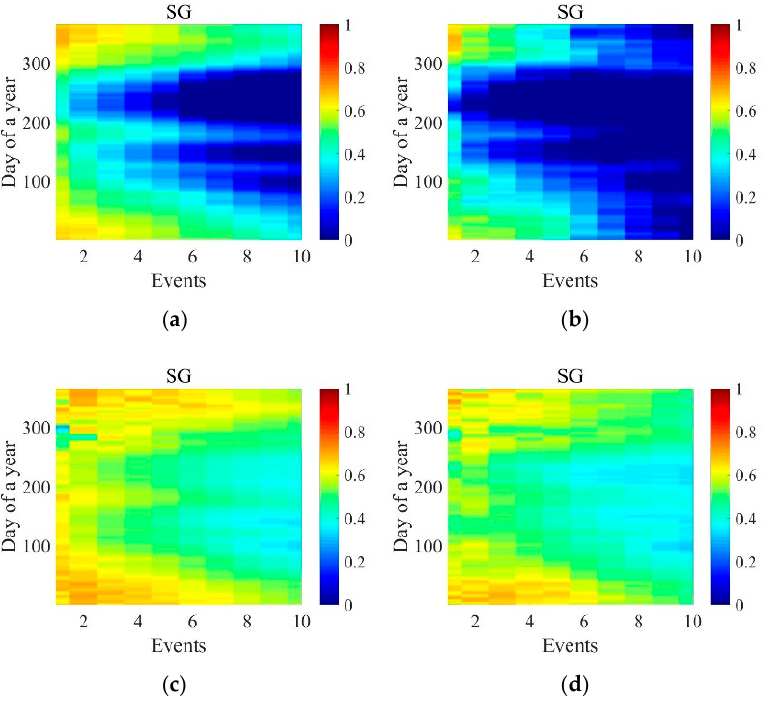
Figure 12. The CRPSS results of Scheme 3 for Shaoguan: ( a ) raw GEFS; ( b ) raw CFSv2; ( c ) post-processed GEFS; and ( d ) post-processed CFSv2.